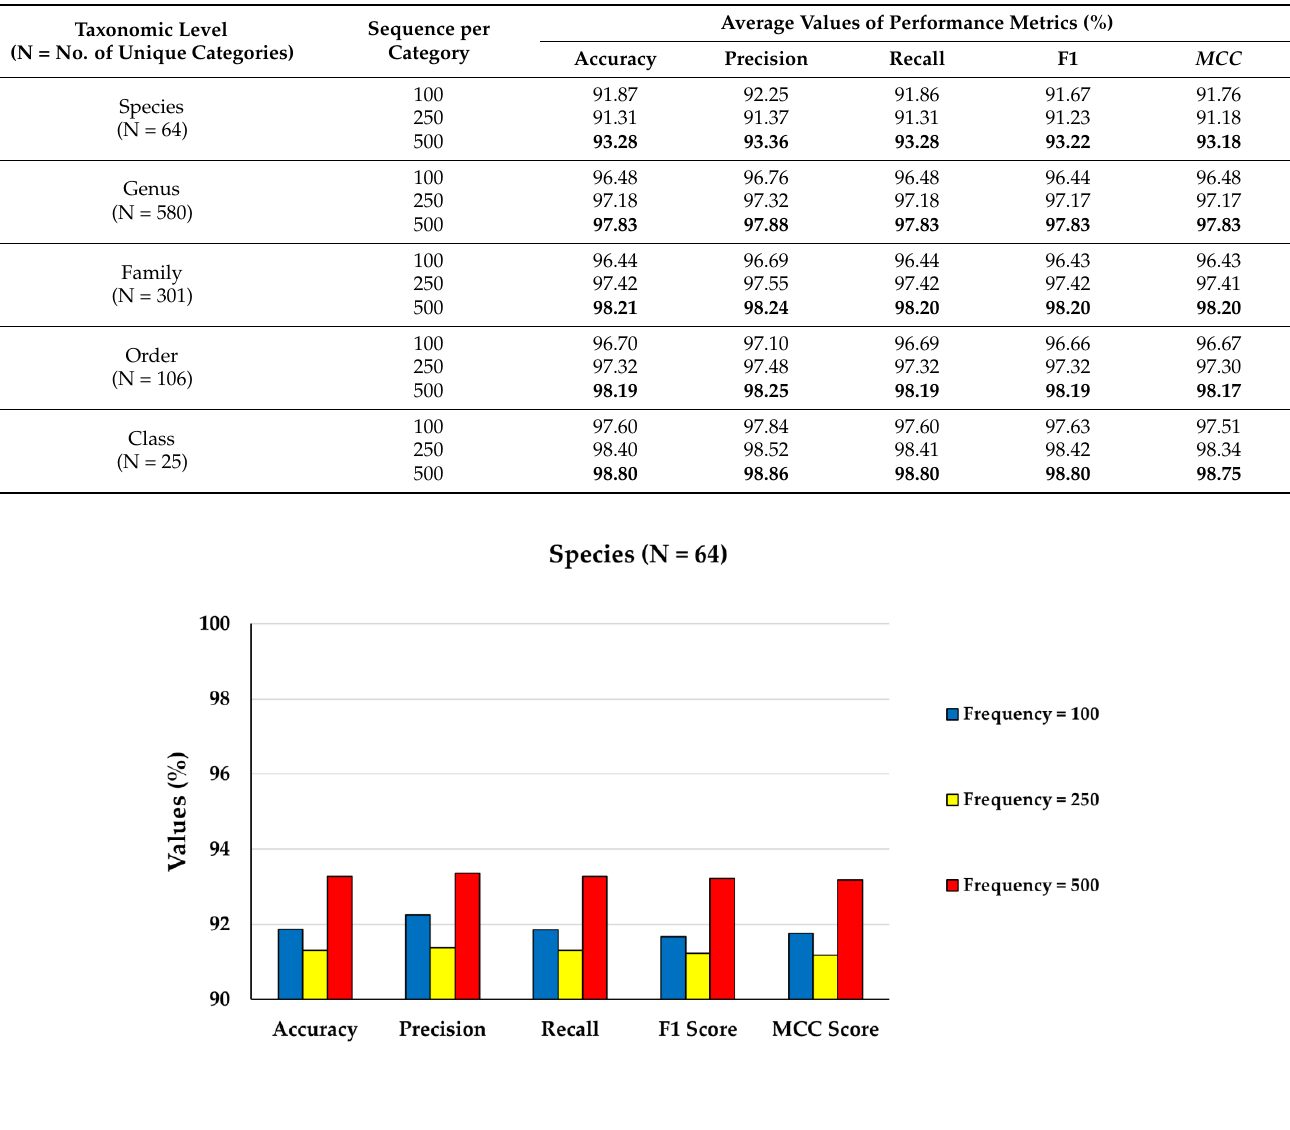
Table 6. Performance evaluation of CNN classifiers for datasets with unchanged diversity levels and hexanucleotide ( k = 6) frequency features at various taxonomic levels. Highest values are highlighted in bold.